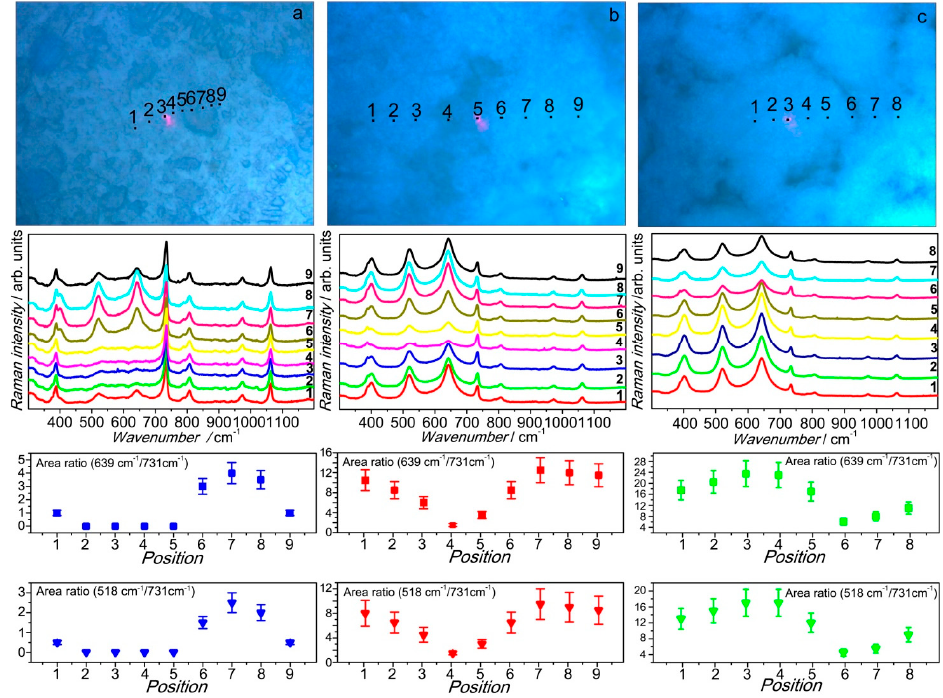
Figure 11. Raman mapping of the three composite membranes: 2-TiO 2 -S ( a ) 5-TiO 2 -S ( b ) and 7-TiO 2 -S ( c ). For each sample, the upper panel shows the optical microscopy image, the middle one the Raman spectra in the different samples. The red spot observed in the optical images is the laser beam, whose size is of the order of 1 micron.